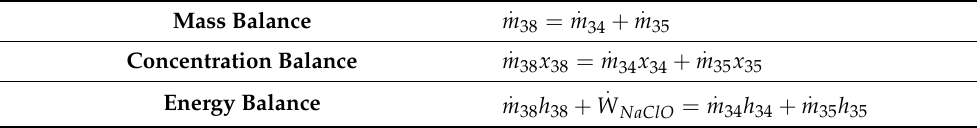
Table 4. Mass, energy, and concentration balance relationships for the NaClO